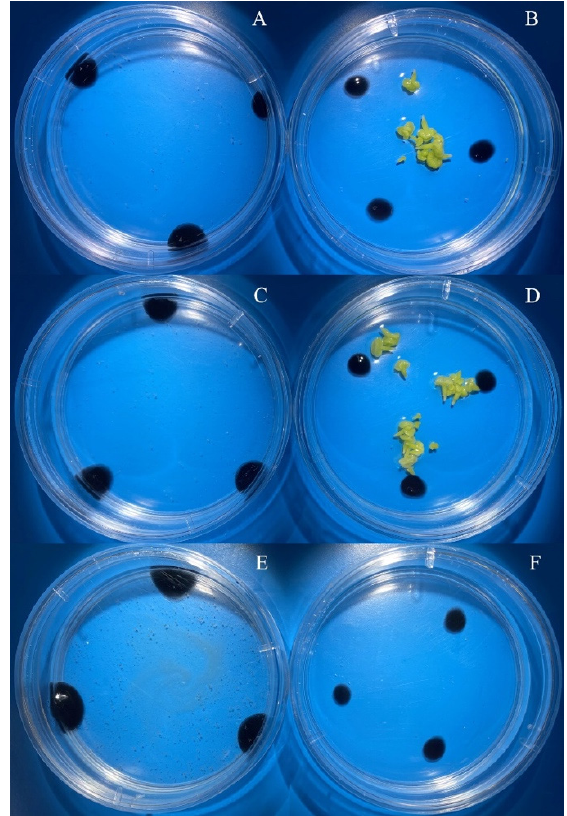
Figure 6. Yield of red cabbage embryoids breeding accession № 428 at day 30 of culture as a function of isolation method and linear bud size. ( A , C , E )—microspore isolation № 2; ( B , D , F )—microspore isolation № 3; ( A , B )—bud size 3.5–4.0 mm; ( C , D )—bud size 4.0–4.5 mm; ( E , F )—bud size 4.5–5.0 mm.